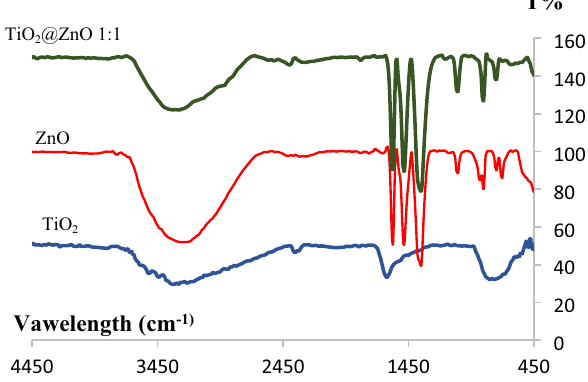
Figure 1. FT-IR spectra of ZnO and TiO 2 quantum dots and their composites.